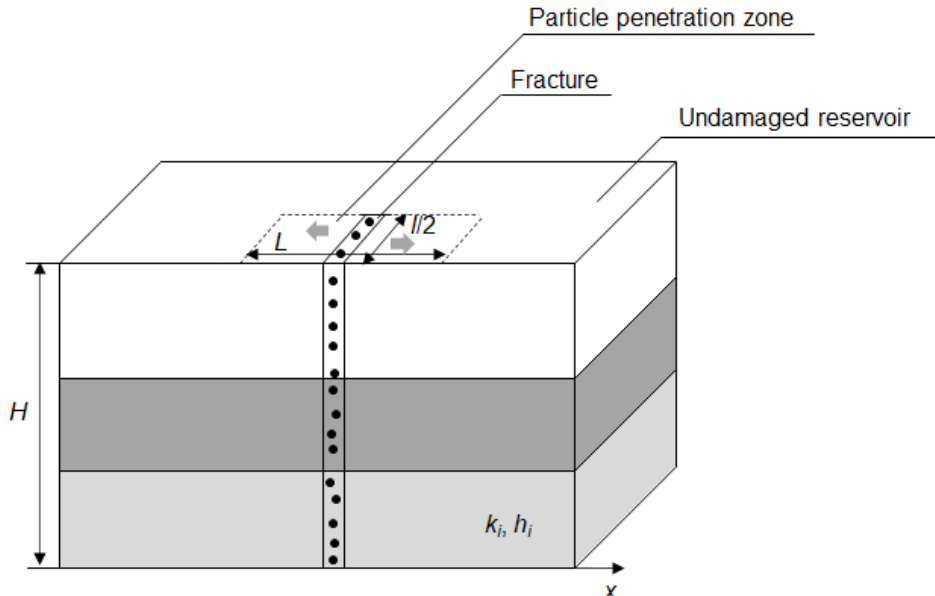
Figure 1. Schematic view of a suspension injection process in the layered strata through a fracture. Because the injection volume of the suspension system is relatively small, vertical crossflows between interlayers may be neglected [25] and layers are considered to be isolated from each other. The fracture is assumed ideal, that is, the proppant resistance in the fracture may be neglected. A small injection volume is also the reason to consider the fluid outflow from the fracture to be one-dimensional flat geometry. Equations (2) – (4) under the adopted assumptions and formulated for the i -th layer are as follows: